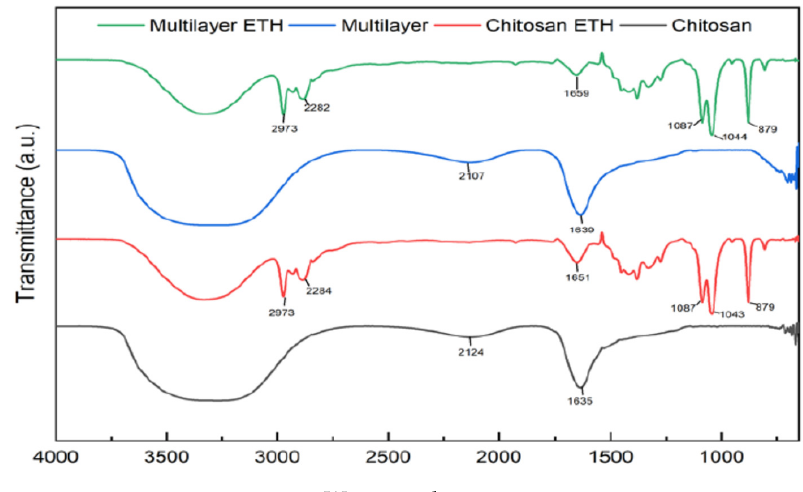
Figure 4. FTIR spectra of chitosan film and multi-layered film soaked in water and FTIR spectra of chitosan film and multi-layered film soaked in ethanol.